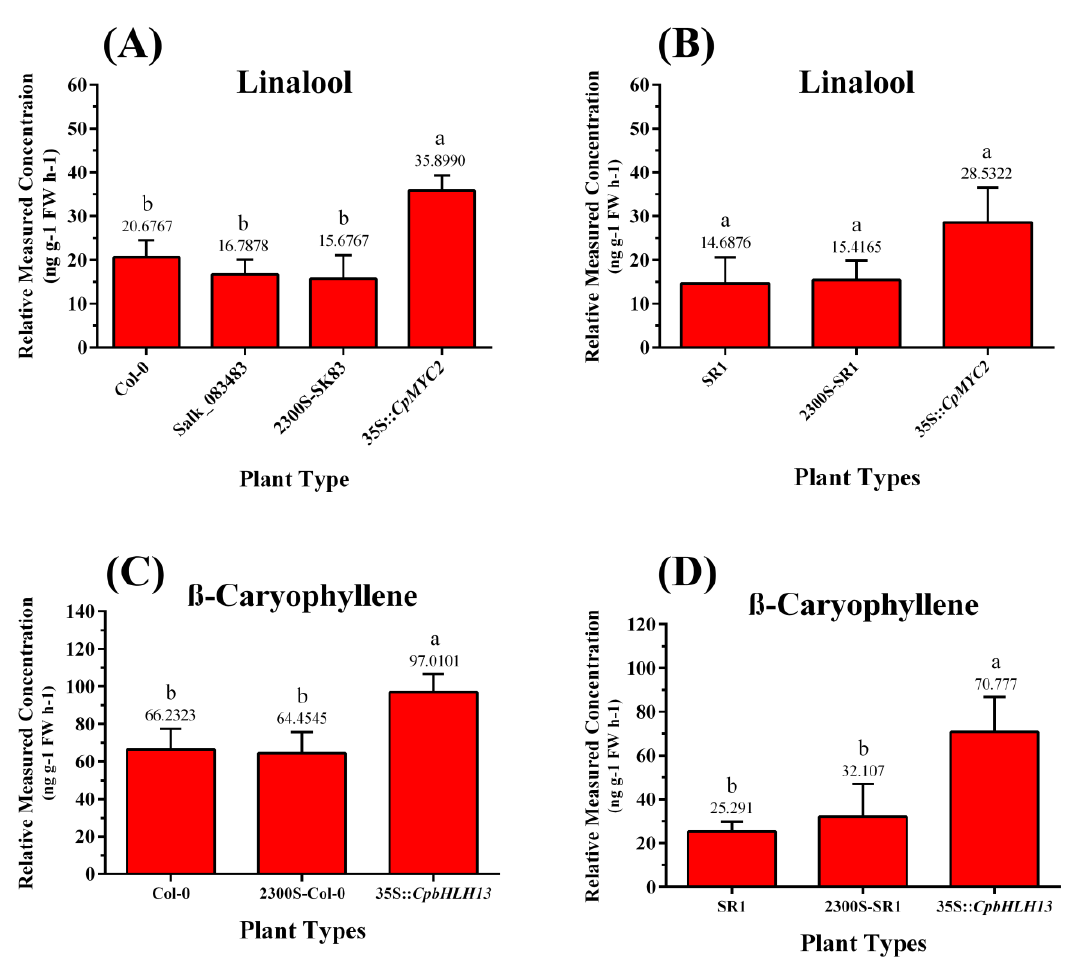
Figure 6. The concentration of emitted linalool (ng g-1 FW h-1) from ( A ) arabidopsis wild type (WT-Col-0), mutant (Salk_083483), mutant Salk_083483 transformed by the empty vector pCAMBIA2300S (2300S-Sk83) and overexpressed CpMYC2 gene (35S:: CpMYC2 ), and ( B ) tobacco wild type SR1, transformed by the empty vector pCAMBIA2300S (2300S-SR1) and overexpressed CpMYC2 gene (35S:: CpMYC2 ) plants. Concentration of emitted β -caryophyllene (ng g-1 FW h-1) from ( C ) arabidopsis wild type (WT-Col-0), wild type transformed by empty vector pCAMBIA2300S (2300S-Col-0) and overexpressed CpbHLH13 gene (35S:: CpbHLH13 ), and ( D ) tobacco wild type SR1, transformed by the empty vector pCAMBIA2300S (2300S-SR1) and overexpressed CpbHLH13 gene (35S: :CpbHLH13 ) plants. The di ff erent letters on the bars show significance between the treatments by using least significant di ff erence (LSD) at p < 0.05.